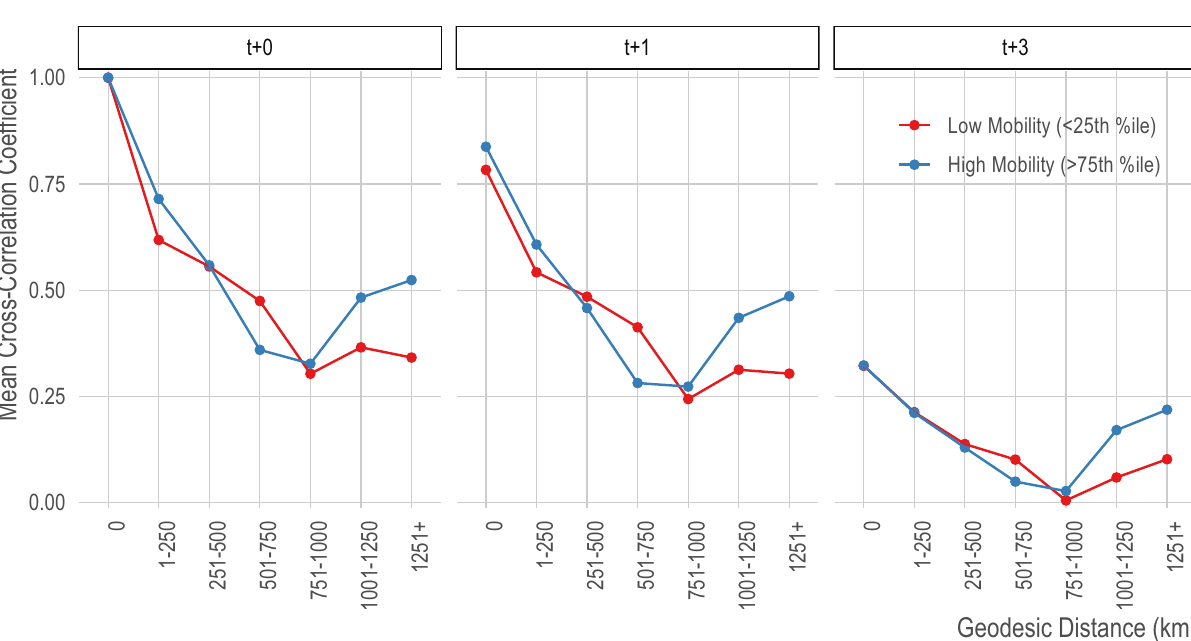
Figure 7. Correlation of province-level dengue by distance, at different time lags. We show the mean cross- correlation coefficient (y-axis) for pairs of provinces at binned distances (x-axis; 0 indicates correlation of an area with itself) for synchronous dengue (left panel) and lagged by 1 month (middle panel) and 3 months (right panel). The lines are separated based on the connectivity of pairs of provinces where the red line shows the bottom quartile of provinces in terms of incoming and outgoing travel and the blue line shows the top quartile. Bangkok, an important travel hub, is in the approximate center of Thailand and between 700 and 800 km from all other provinces, therefore the last two distance categories do not include